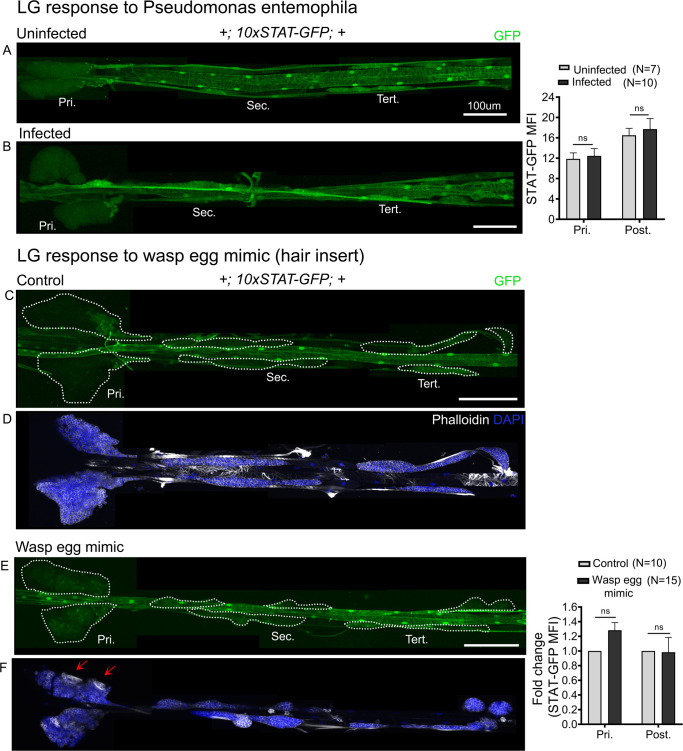
10xSTAT-GFP reporter activity in response to bacterial infection and wasp egg mimic.(A and B) 10xSTAT-GFP reporter activity (green) remains unchanged upon Pseudomonas entemophila infection. Uninfected larval lymph gland (A) compared with Pseudomonas entemophila infected lymph gland (B). Graph representing the mean fluorescence intensity (MFI) for 10xSTAT-GFP is plotted. Mann–Whitney nonparametric test was used for statistical analysis. (C–F) 10xSTAT-GFP reporter (green, C and E) and Phalloidin (white, D and F) in control (C and D) and wasp egg mimic conditions (E and F) show no change in reporter activity. (F) Lamellocytes in the primary lobes are shown (red arrows). Graphs represent MFI for 10xSTAT-GFP. Student's t-test is used for calculating fold change, error bars represent SEM. *p<0.05, **p<0.01, ***p<0.001, and ns indicates nonsignificant. Pri. indicates primary lobes, Sec. indicates secondary lobes, Tert. indicates tertiary lobes, and Post. indicates posterior lobes. (A–F) Scale bar: 100 µm.Figure 5—figure supplement 2—source data 1.Numerical data plotted and statistical analysis related to Figure 5—figure supplement 2.